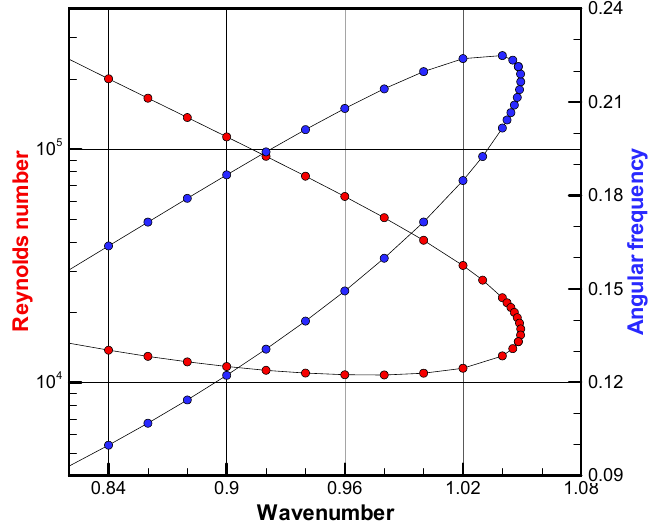
Figure 6. Neutral stability curves in the vicinity of the critical point for Ha = 1.